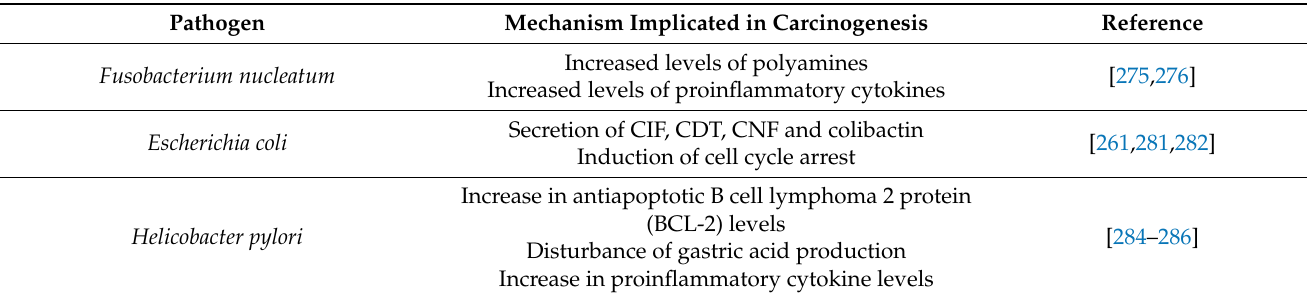
Table 4. Summary of pathogen mechanisms implicated in